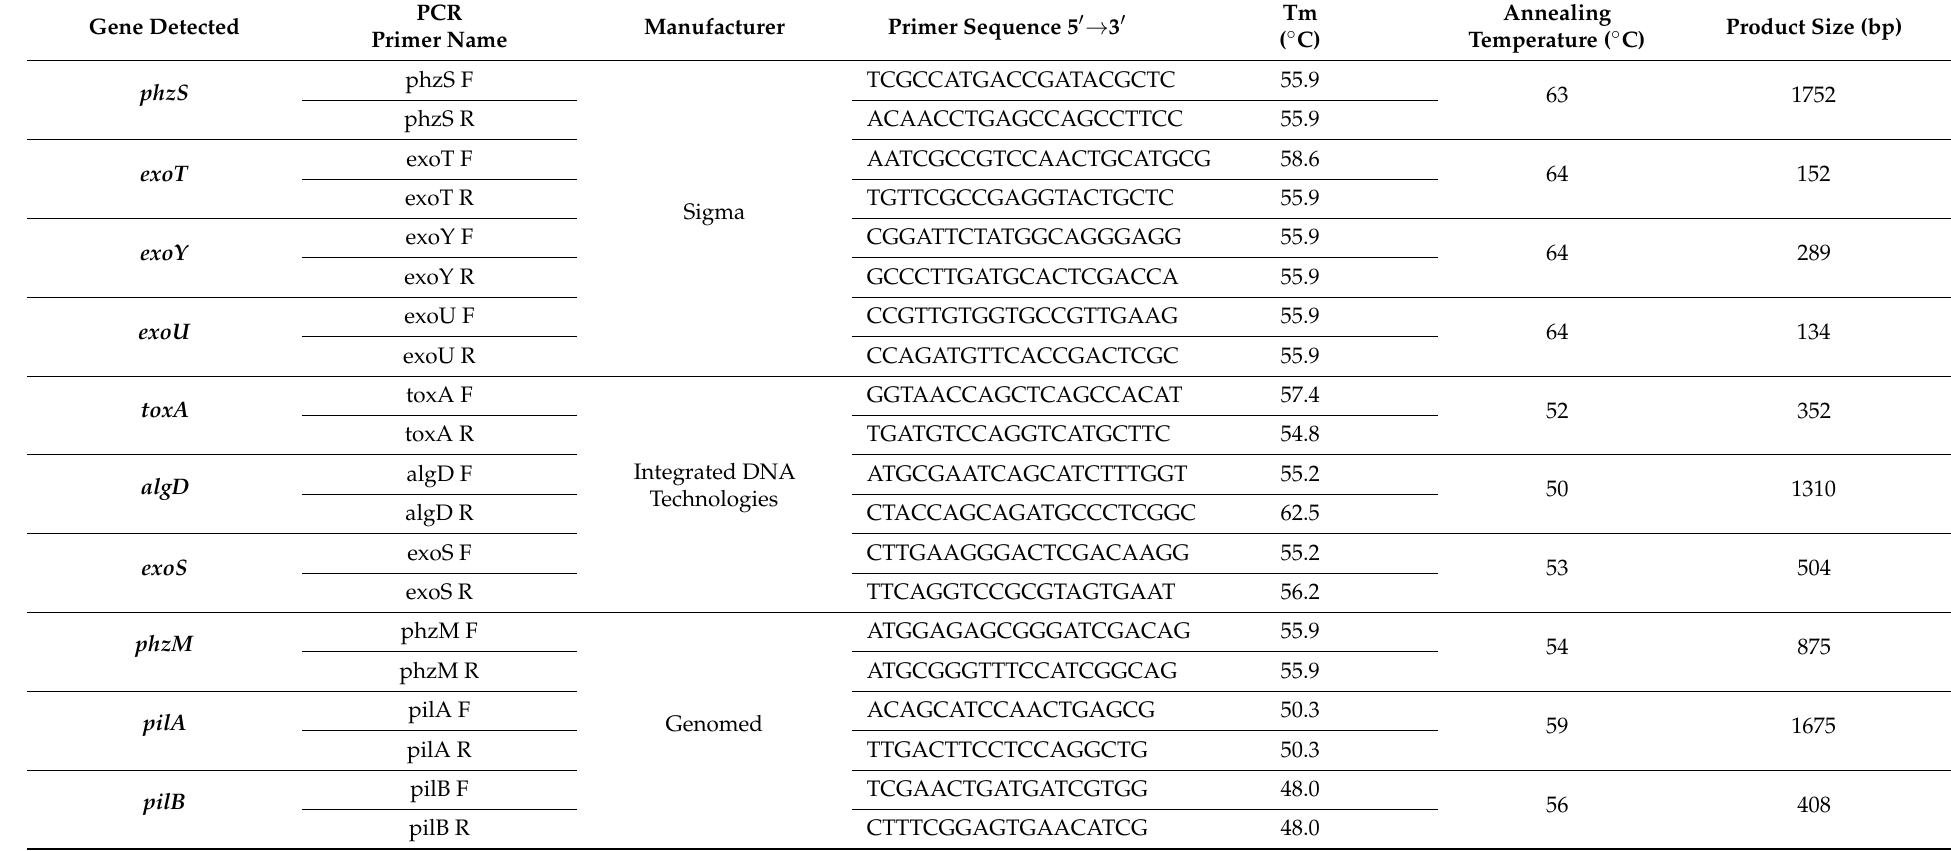
Table 2. The PCR primers’ specification and the PCR parameters applied in the present